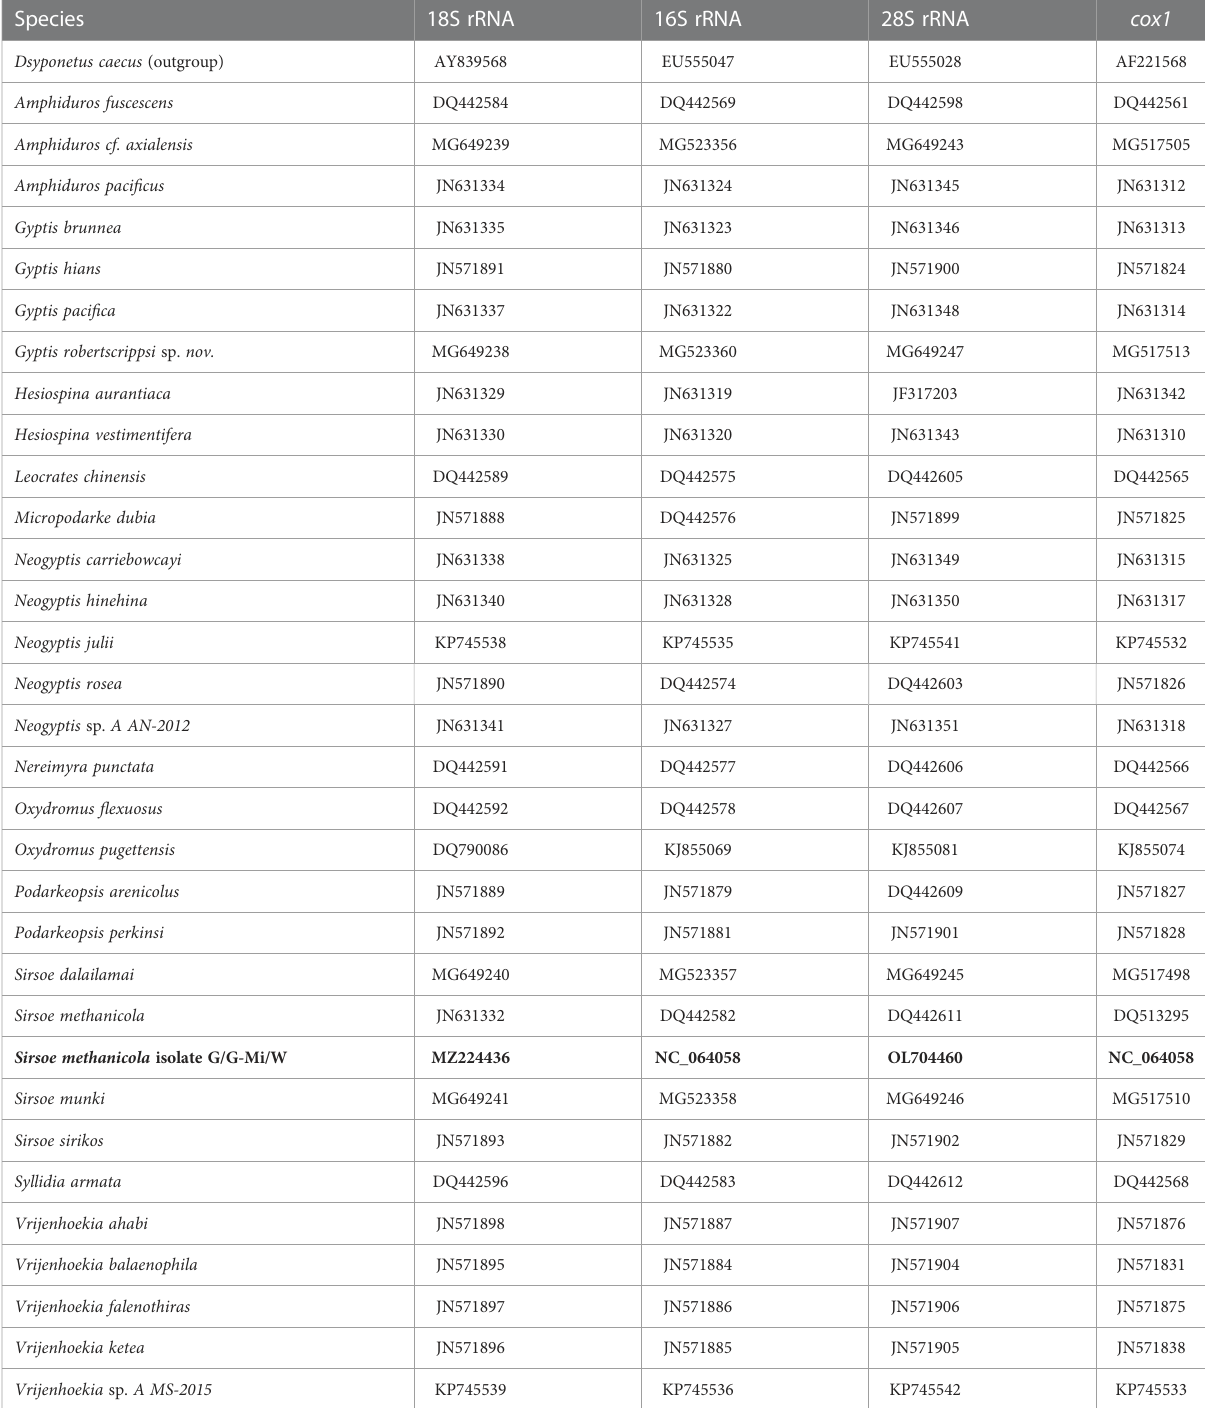
TABLE 2 GenBank accession numbers for Hesionidae and Chrysopetalidae (outgroup) species used for phylogenetic analysis. Sirsoe methanicola sequences assembled from this study are highlighted in bold. Species 18S